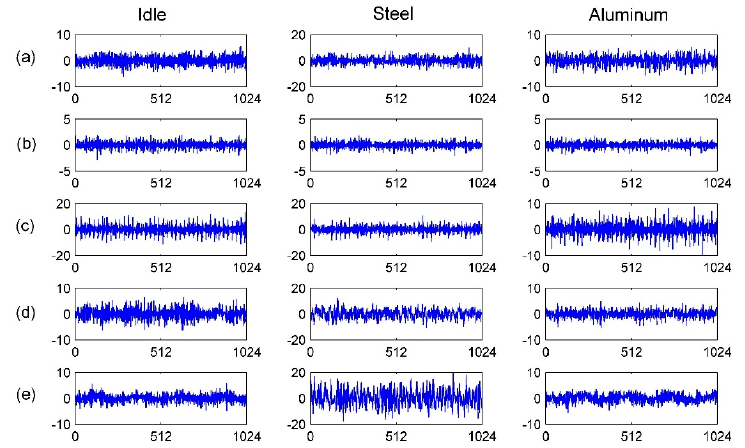
Figure 14. Raw vibration signals under 6000rpm and the five health states: ( a ) normal; ( b ) inner race fault; ( c ) outer race fault; ( d ) retainer broken fault; ( e ) lubrication shortage fault. Table 10. Details of the two datasets in Case Two.